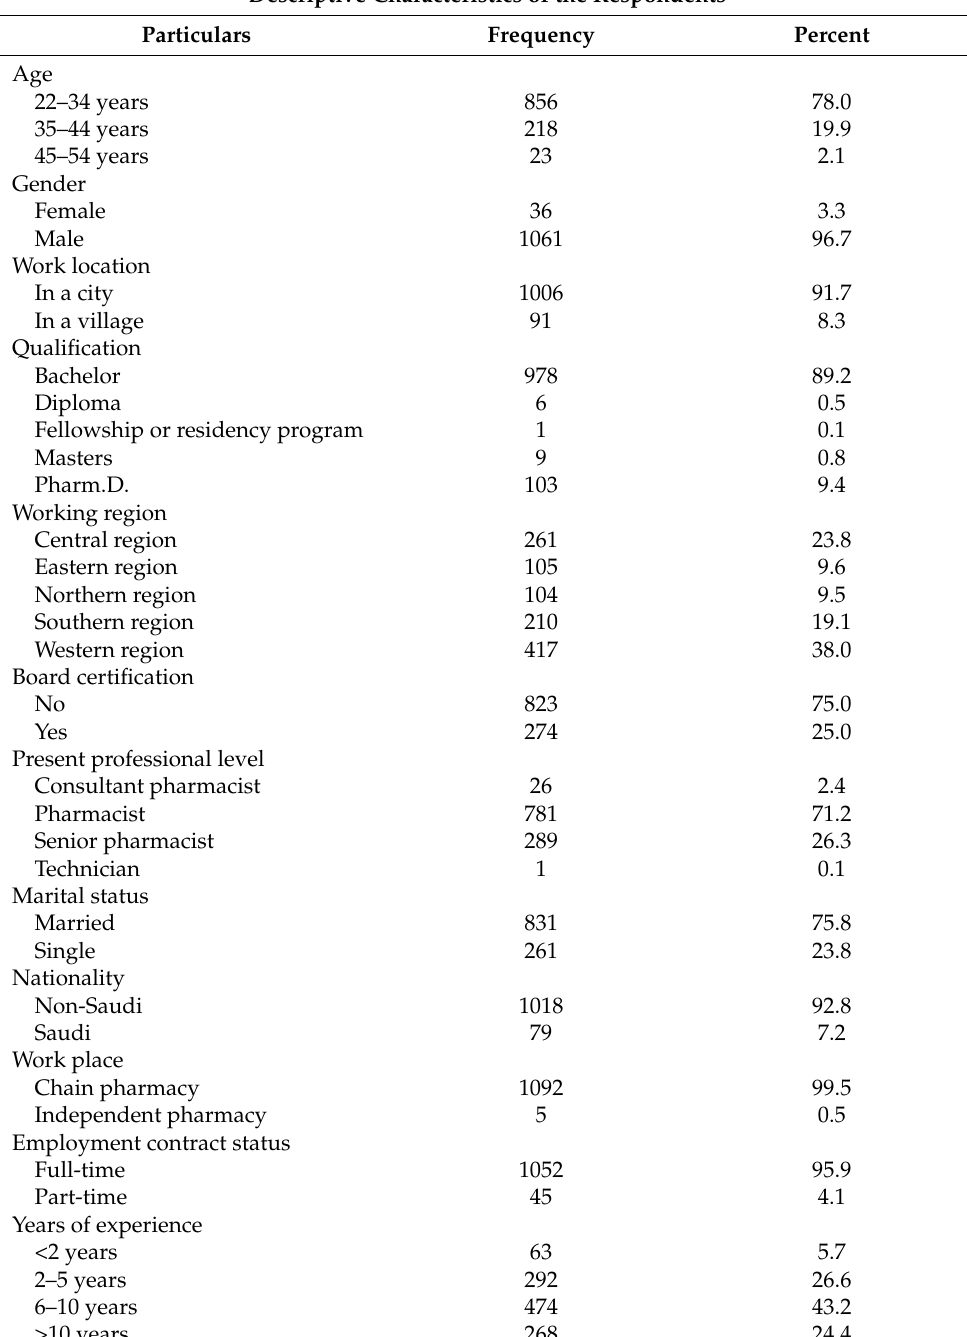
Table 1. Demographic characteristics of survey